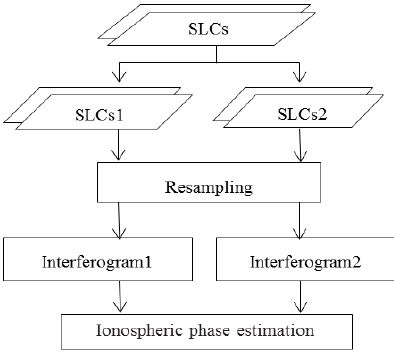
Figure 1. Overview of IPS processing flowchart